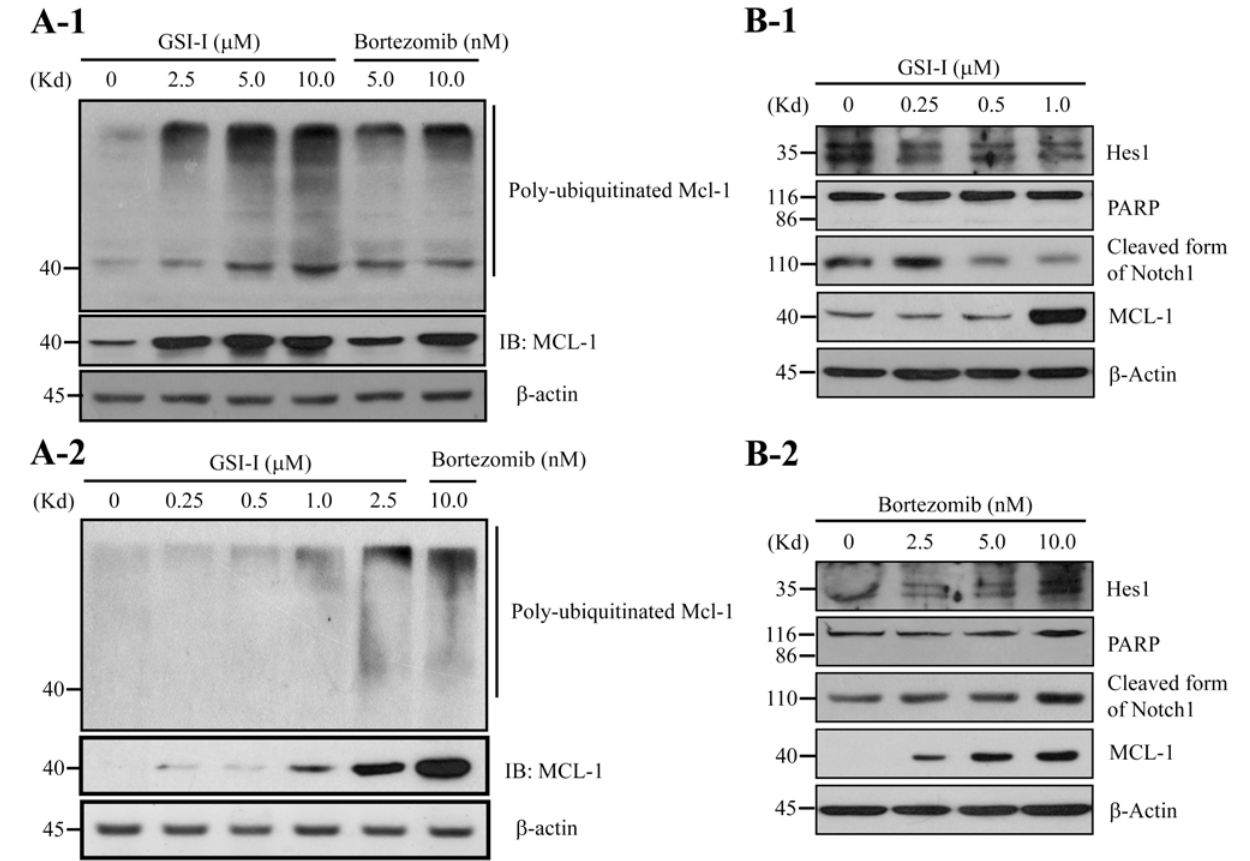
Fig 5. The GSI-I treatment inhibits both Notch and ubiquitin-proteasome signaling in hUC-MSCs. A. Both GSI-I and Bortezomib inhibit ubiquitin- proteasome signaling. The Western blotting following immunoprecipitation shows that the treatment with 1.0 – 10.0 μ M GSI-I or 5 – 10 nM Bortezomib significantly elevates the level of ubiquitin-conjugated Mcl-1 protein. A-1 is from the data using 2.5 μ M-10.0 μ M of GSI-I and 2.5 – 5 nM Bortezomib and A-2 is from the data using 0 – 2.5 μ M of GSI-I and 10 nM of Bortezomib. B. GSI-I, but not Bortezomib, inhibits the Notch signaling. The Western blotting shows that, whereas 0.25 – 1 μ M GSI-I reduce levels of the cleaved form of Notch1 and Hes1 proteins (B-1), 2.5 – 10 nM Bortezomib however significantly increase Hes1 protein level